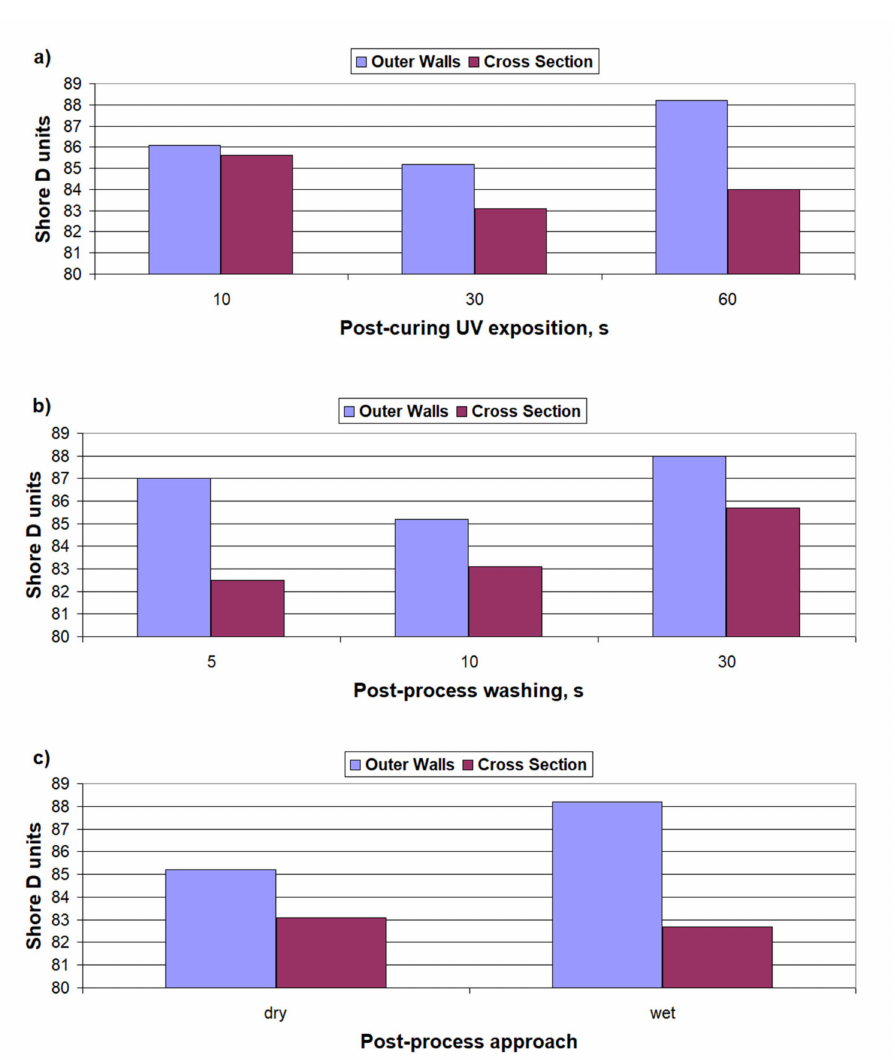
Figure 5. Shore D hardness of printed samples, depending on the following: ( a ) post-curing exposi- tion time, ( b ) post-process washing time, ( c ) post-process approach—post-curing in water